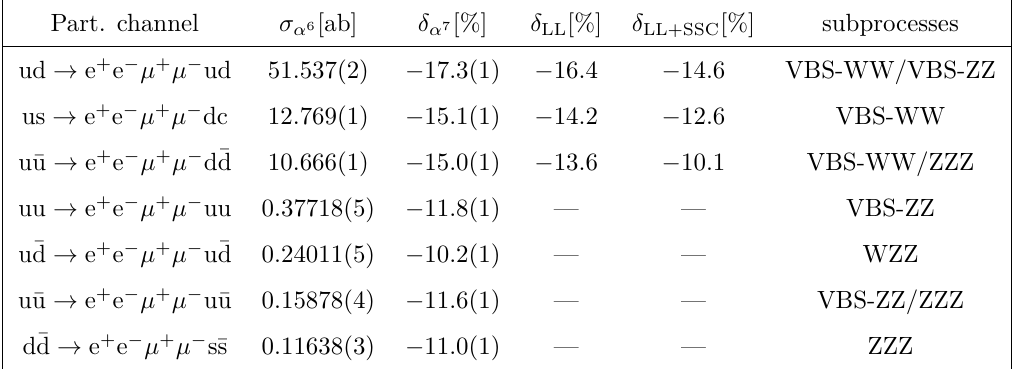
Table 4. Relative EW-NLO corrections δ responding corrections in the Sudakov approximation without ( δ LL ) and with ( δ LL+SSC ) angular- dependent logarithms. Contributing subprocesses are indicated in the last column, and digits in parentheses indicate the integration